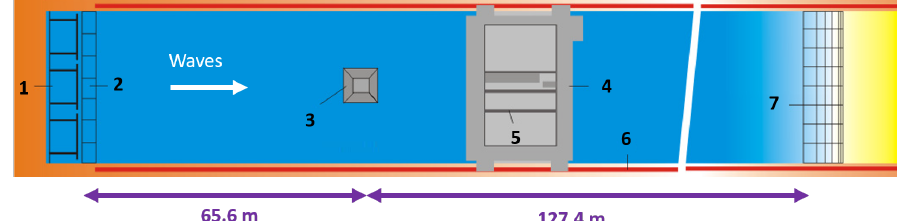
Figure 8. Schematic overview of the shallow water basin. 1: Piston-type wave generator. 2: Strips to reduce cross-wave resonance. 3: Pit where wind turbine was mounted. 4: Measurement carriage.